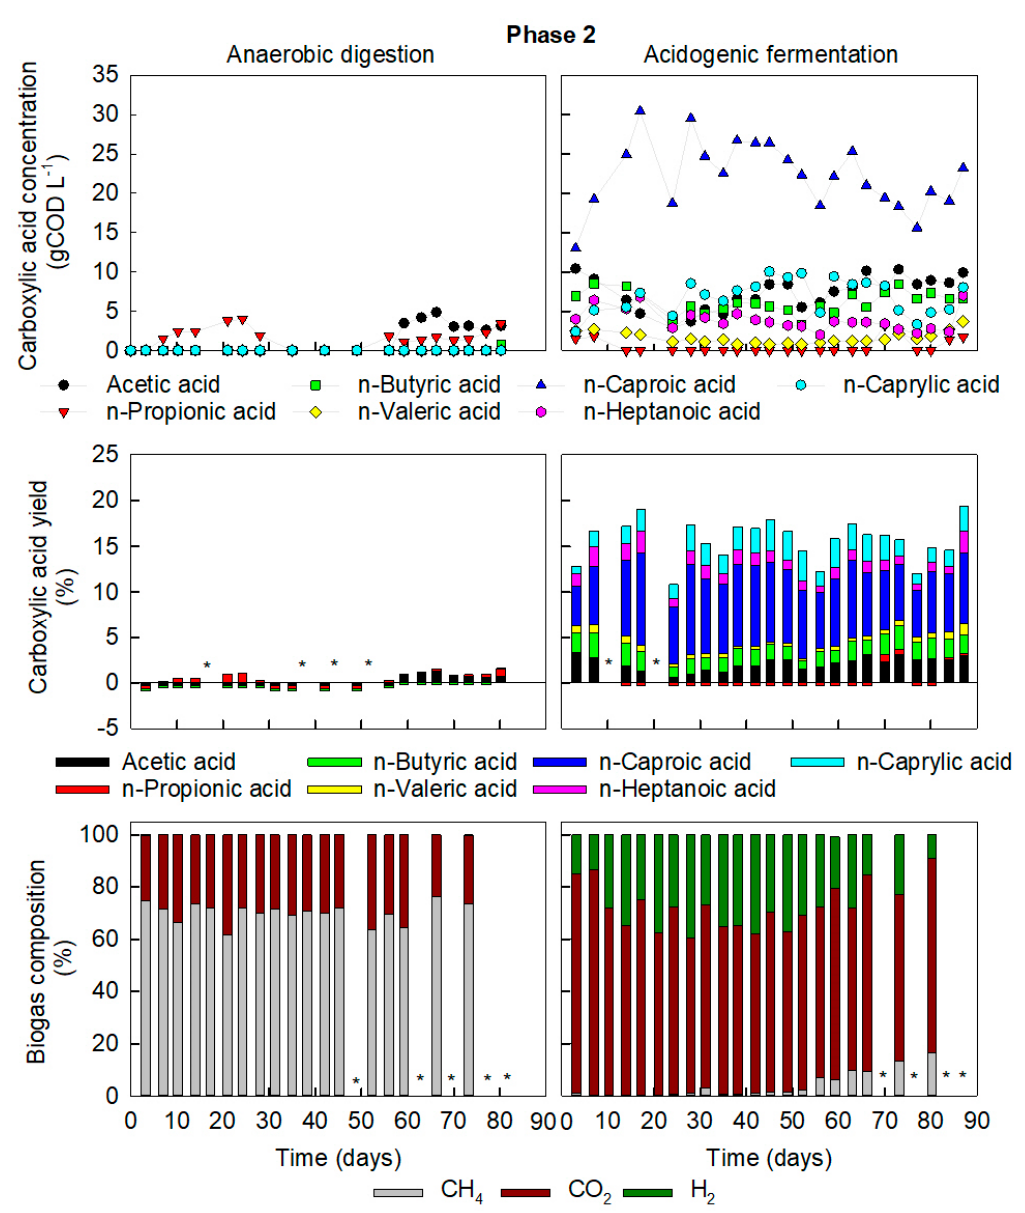
Figure 2. Key chemical compounds in Phase 2 of reactor operation in AD ( left ) and AF ( right ). Concentrations ( top ) and yields ( middle ) of liquid fermentation compounds and biogas composition ( bottom ). * Not determined.